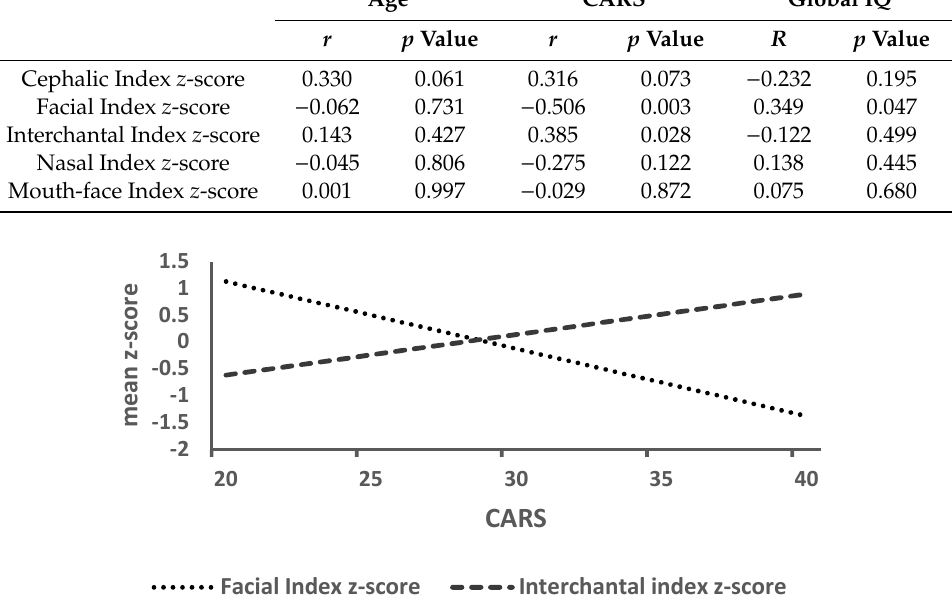
Figure 3. Estimated Facial and Interchantal index z scores related to Cars score.